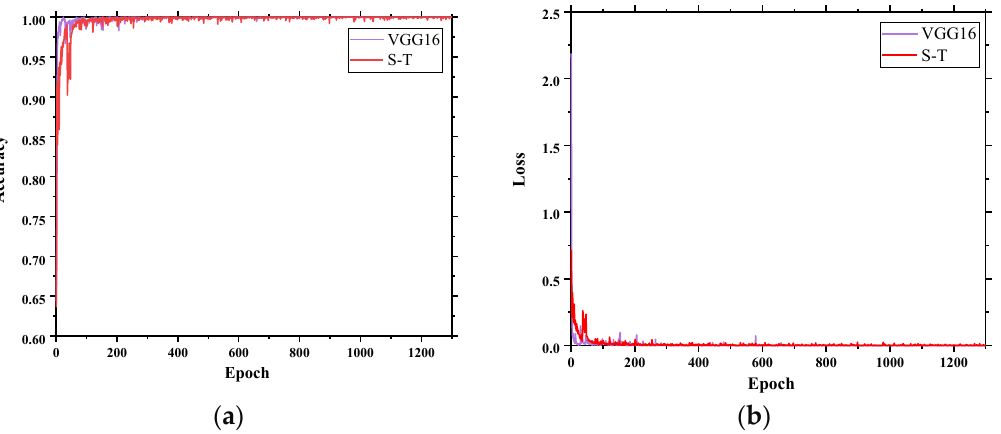
Figure 10. Single-channel VGG16 and S-T models evaluation metrics. ( a ) Accuracy comparison of VGG16 and S-T; ( b ) Loss comparison of VGG16 and S-T.